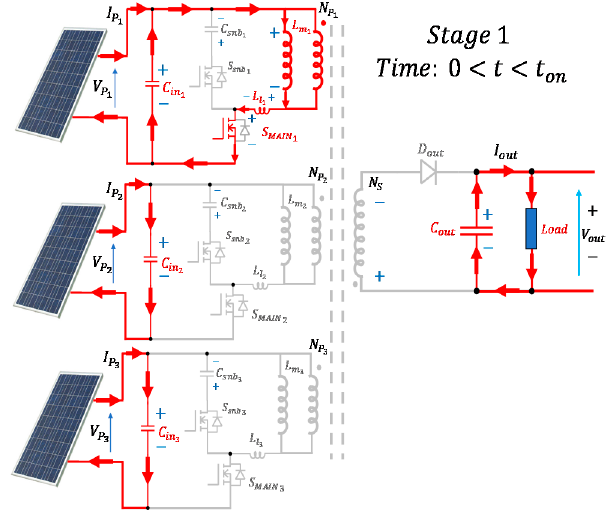
Figure 2. Stage 1, time: 0 < 𝑡 < 𝑡 (cid:3042)(cid:3041) . 2.2. Stage 2: 𝑡 (cid:3042)(cid:3041) < 𝑡 ≤ 𝑡 (cid:2869)